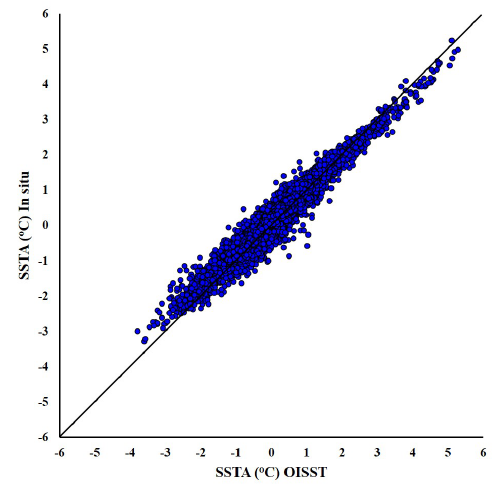
Figure 7. Correlation of the SSTA from the OISST with in situ